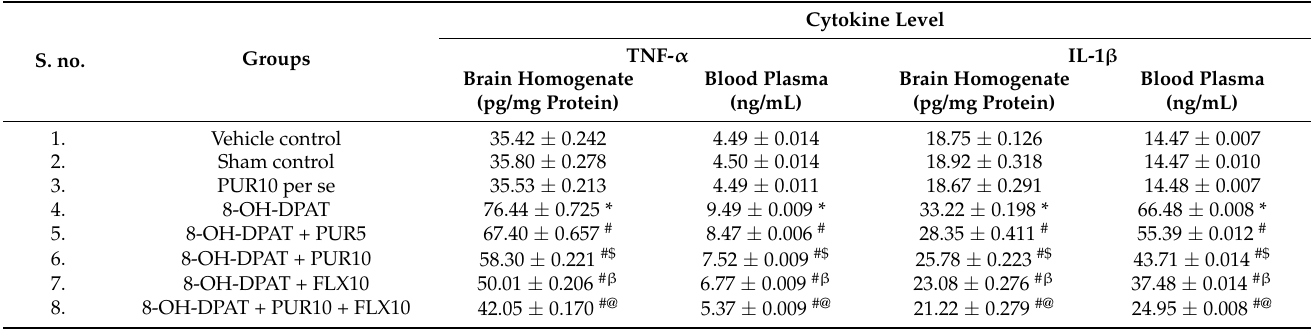
Table 3. Effect of purmorphamine on TNF- α and IL-1 β level in 8-OH OCD.